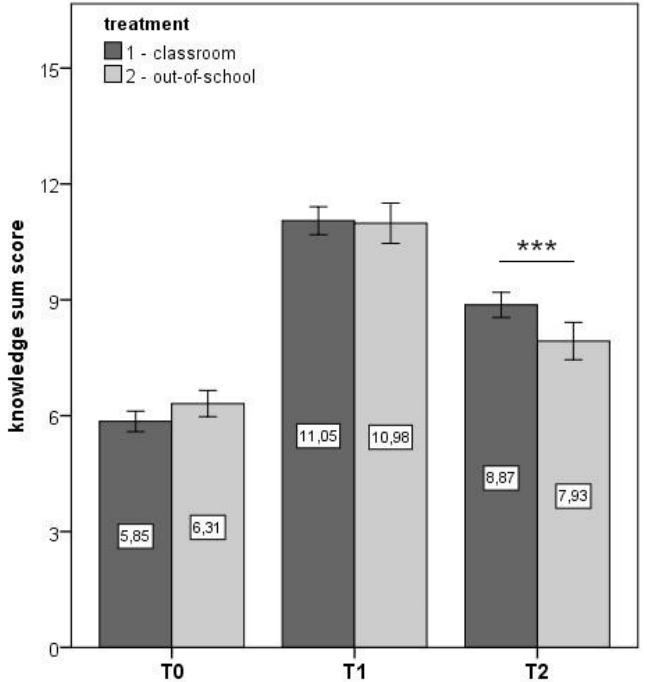
Figure 2. Knowledge sum scores at all test times for both treatment groups; error bars show 95% CI; *** p ≤ 0.001.